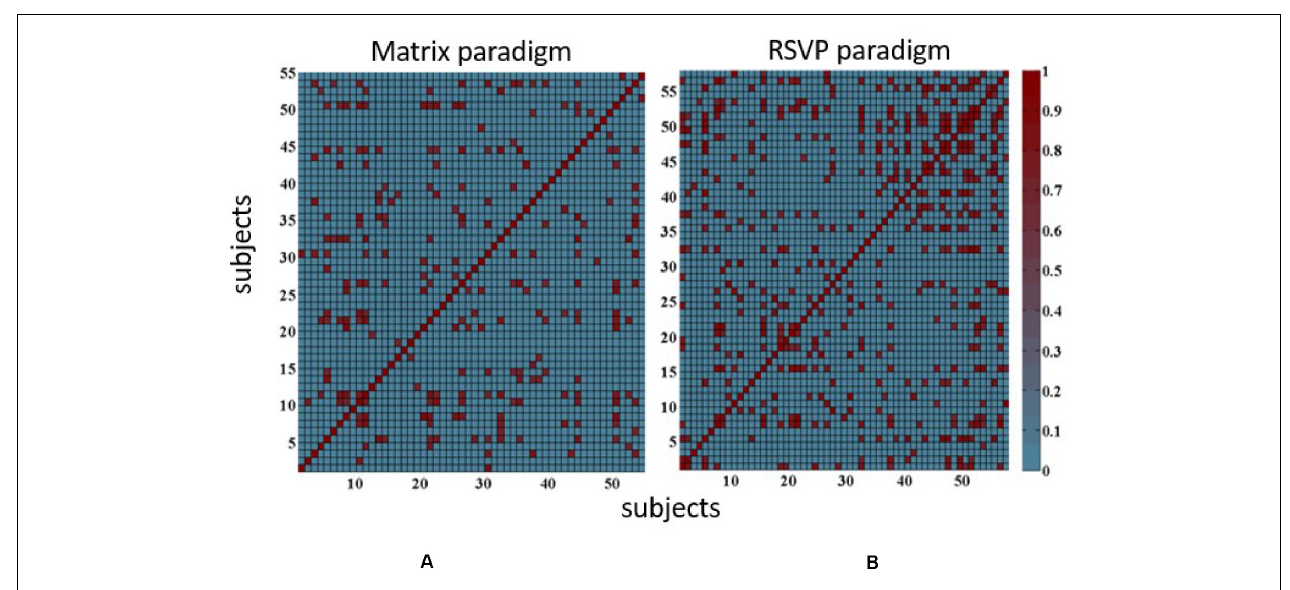
FIGURE 5 | Target ERP waveforms (A) of the same subject from 20 sessions and (B) those from 58 different subjects. In (A) , all lines were from one subject, and each line presented ERP waveform extracted from one session; the black lines represented the average ERP waveforms across all sessions. In (B) , each line presented ERP waveform extracted from one subject averaged over 20 sessions, and the thick lines were the mean values across all subjects.